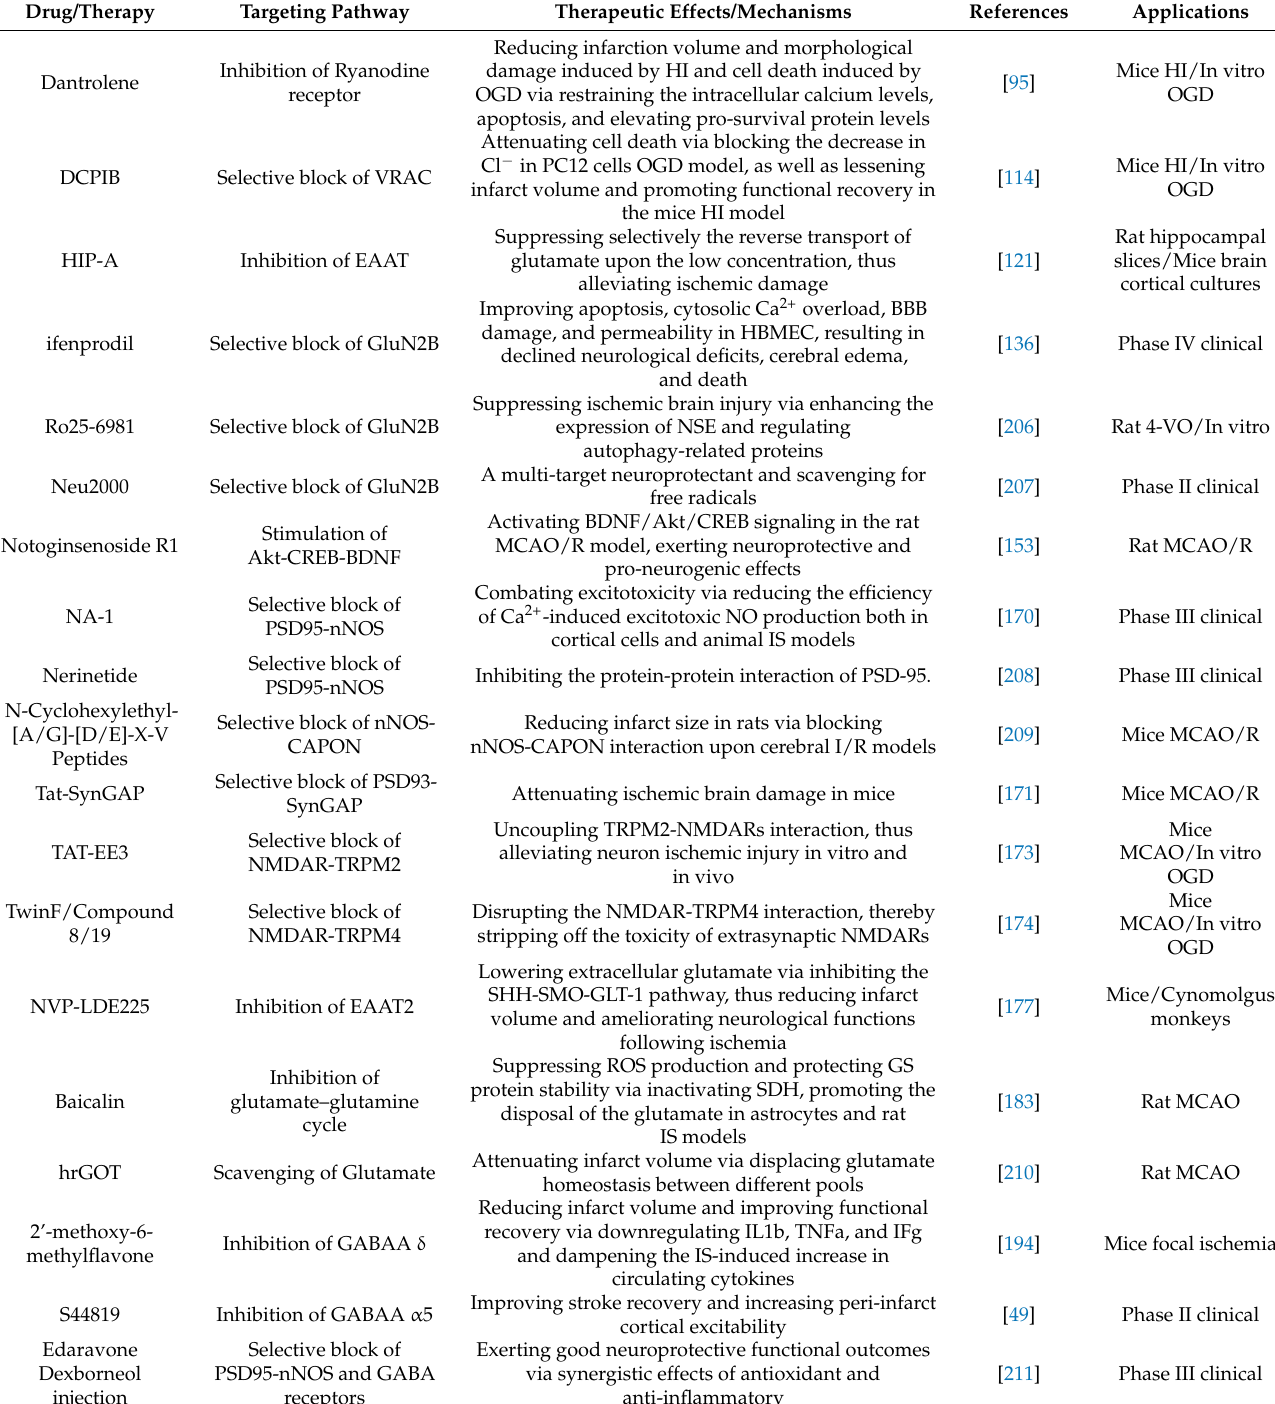
Table 1. Potential therapies for ischemic stroke targeting synaptic transmission